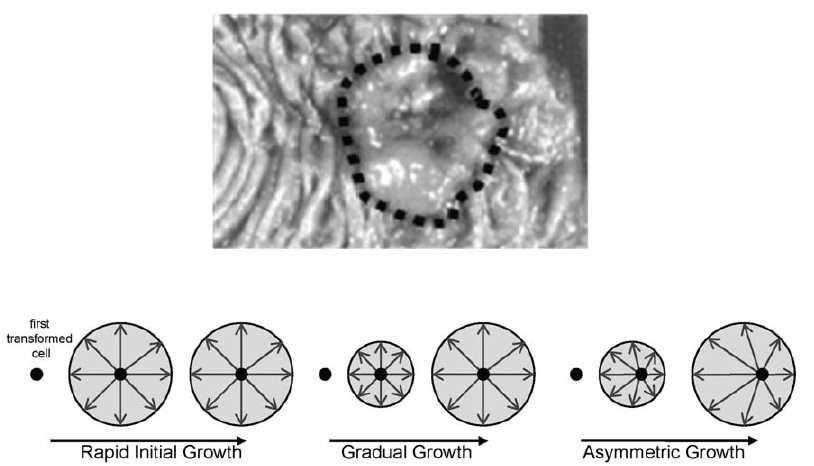
Figure 1. A picture of a colorectal adenocarcinoma with a cartoon illustrating three possible growth models: rapid growth, gradual growth, asymmetric growth.